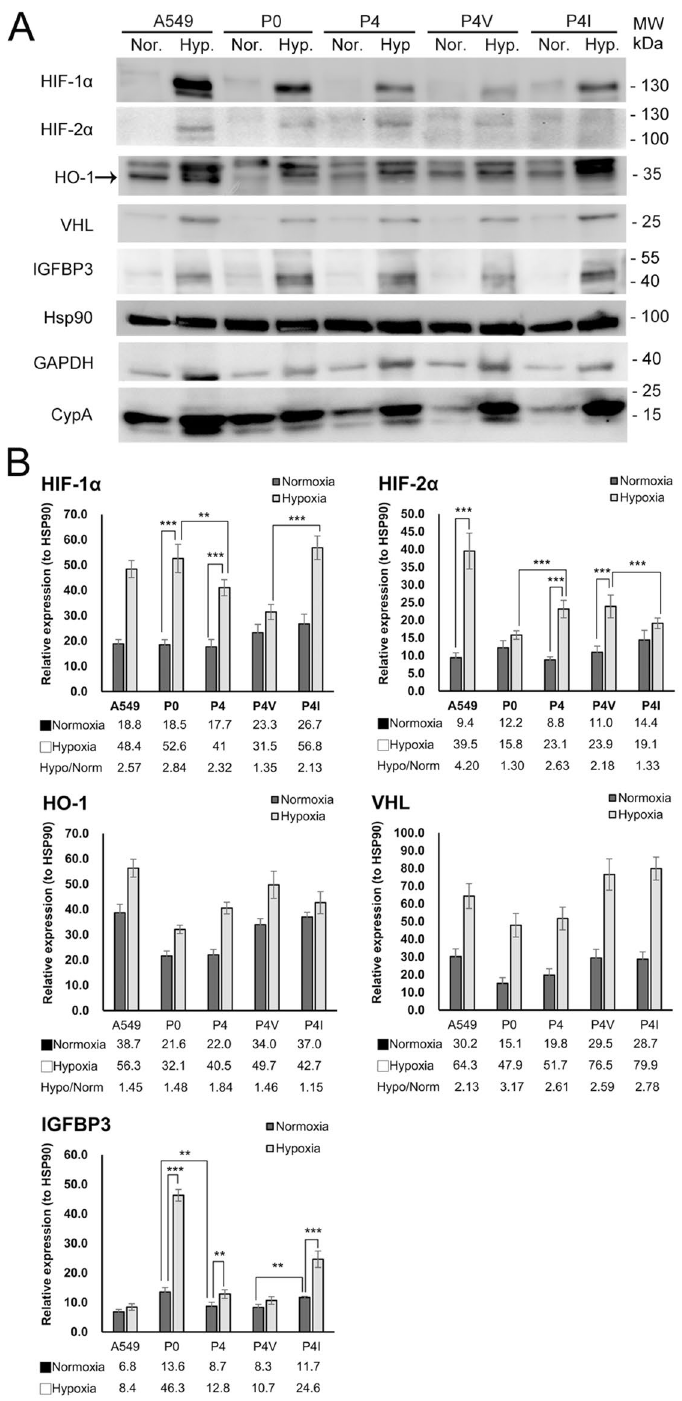
Figure 4. Protein expression analysis of cell cultures under normoxic and hypoxic conditions. ( A ) Western blot analysis of IGFBP3, HIF-1α and HIF-2α, HO-1, VHL, and GAPDH expressions in P0, P4, P4 transfectants, and A549 under normoxic and hypoxic conditions. HSP90 was added as the control. ( B ) Western blot results were transformed into bar figures using Image Studio Lite version 5.2. Signal strengths were quantified and normalized with HSP90. P0 had a higher IGFBP3 expression than P4. In P0 and P4-I, IGFBP3 expression was increased under hypoxia. Accumulation of HIF-1α or HIF-2α correlated with IGFBP3 expressions: a higher IGFBP3 was with a stronger HIF-1α. Both HO-1 and VHL expressions were increased under hypoxia. Each sample was assayed in triplicates, and the experiment was repeated three times independently. (The error bars represent the SDs; ** P < 0.001, *** P < 0.0005). Excel 2016 was used to generate charts. Photoshop CS2 version 9 was used to assemble the